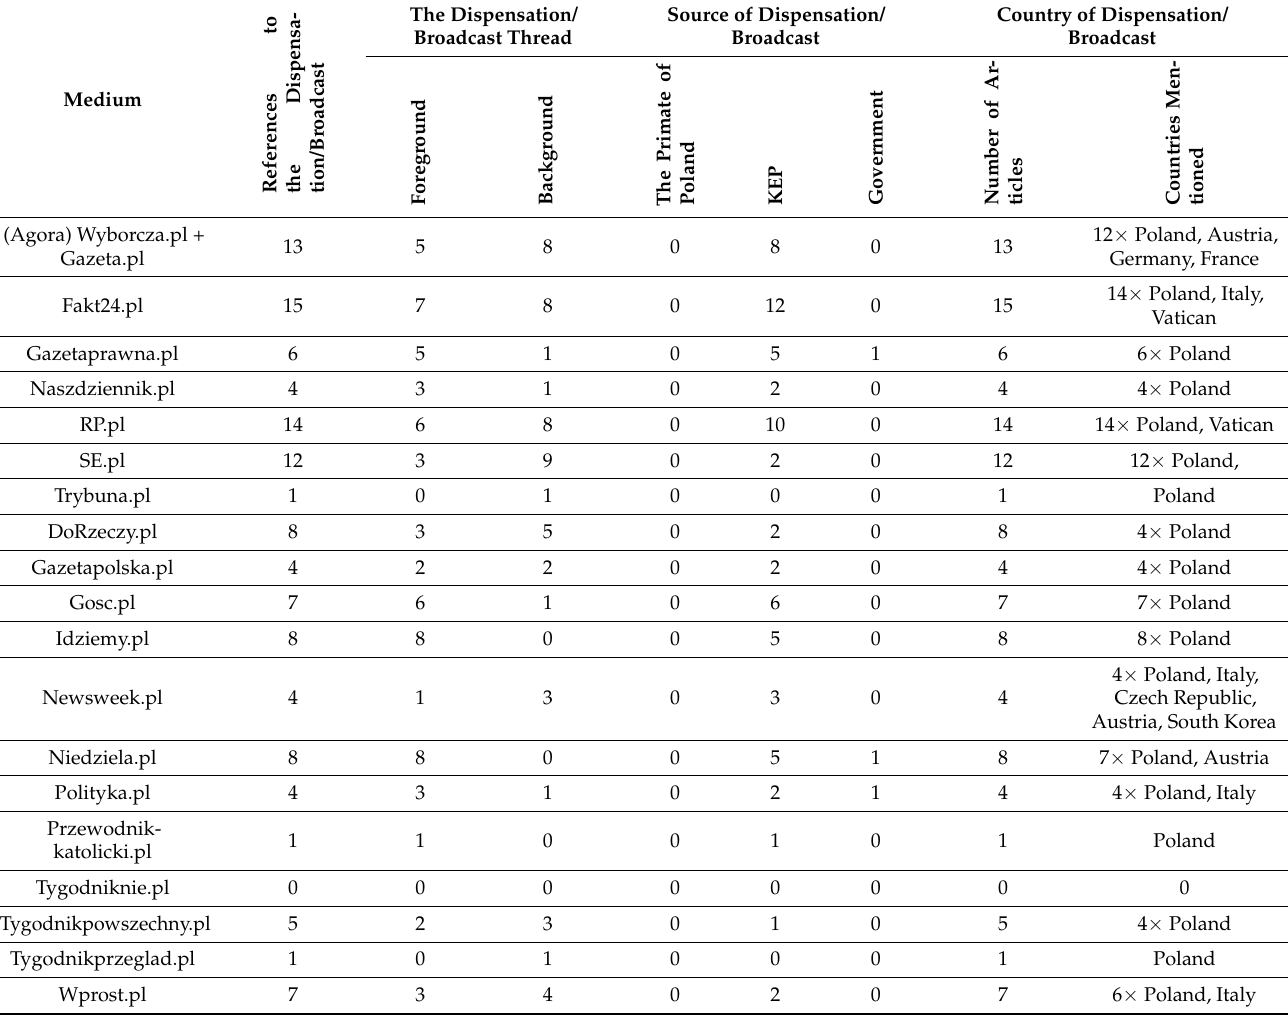
Table 7. Media references to the dispensation/broadcast of